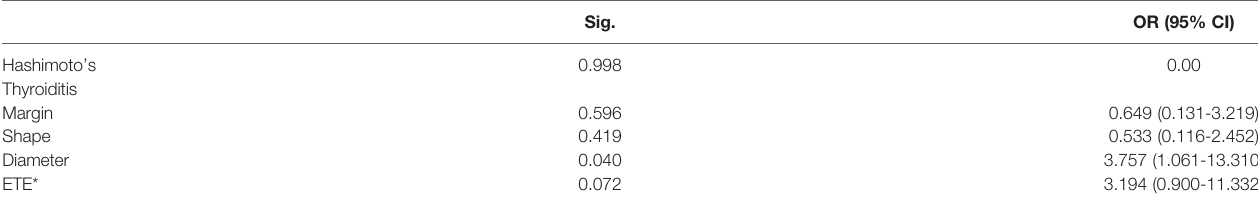
TABLE 6 | Multivariate analysis of the risk factors of CPTC.